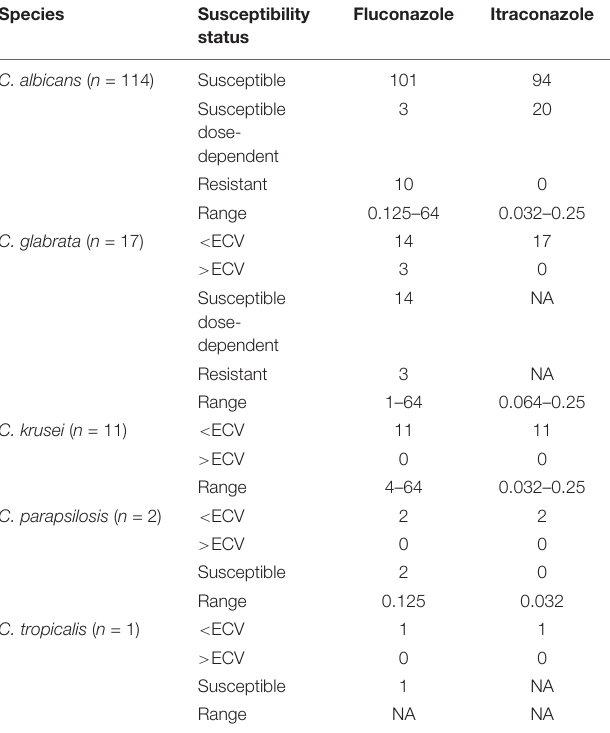
TABLE 3 | Species distribution and fluconazole and itraconazole susceptibility patterns of Candida isolates recovered from Iranian women suffering from VVC and